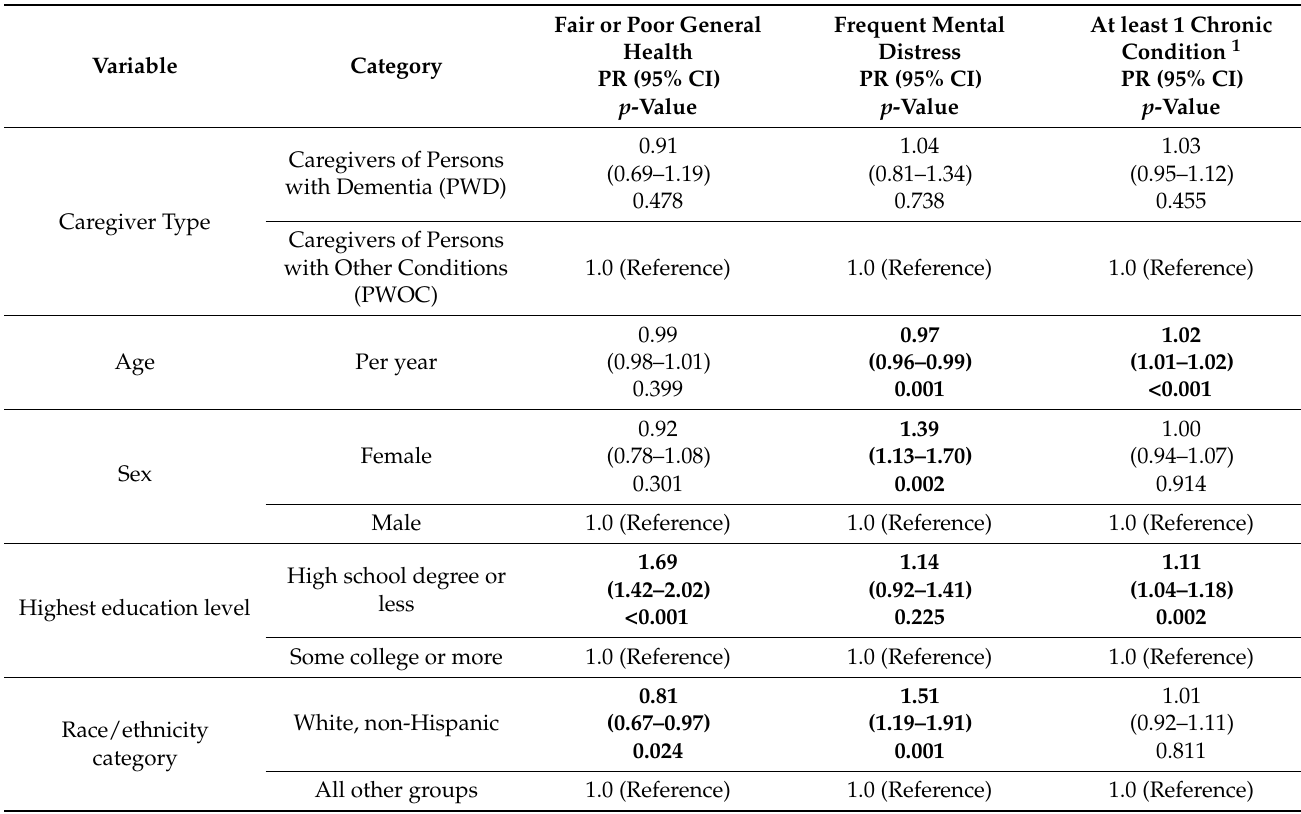
Table 3. Prevalence ratios of fair or poor health, frequent mental distress, or having at least one chronic condition for caregivers of persons with dementia (PWD) based on multivariable log-binomial regression models, Behavioral Risk Factor Surveillance System,